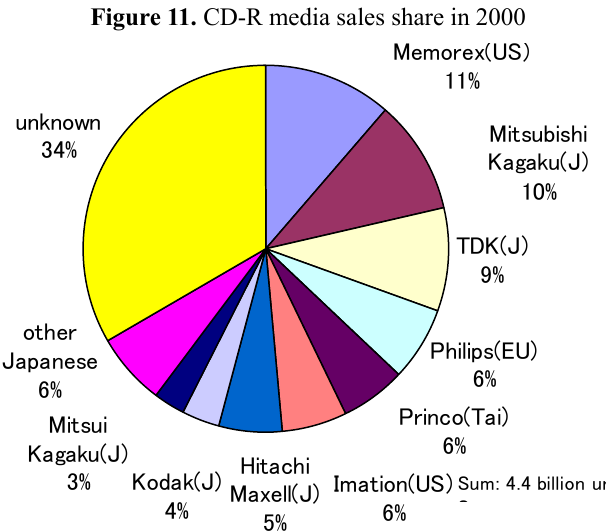
Figure 11. CD-R media sales share in